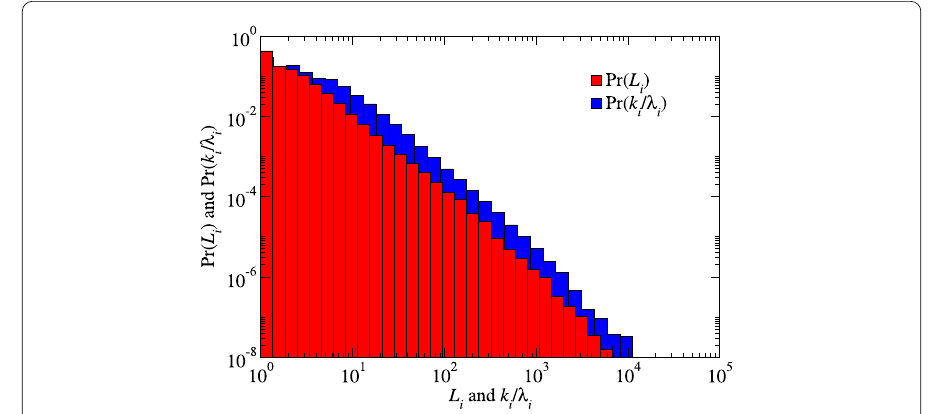
Figure 7 Probability distributions of L i (red) and k i / λ i (blue) for Finland binned logarithmically with 30 bins for the range of values of both sets. For most of the range of L i and k i / λ i , the two distributions are almost parallel, supporting the validity of Eq. (19) to explain Pr( L i